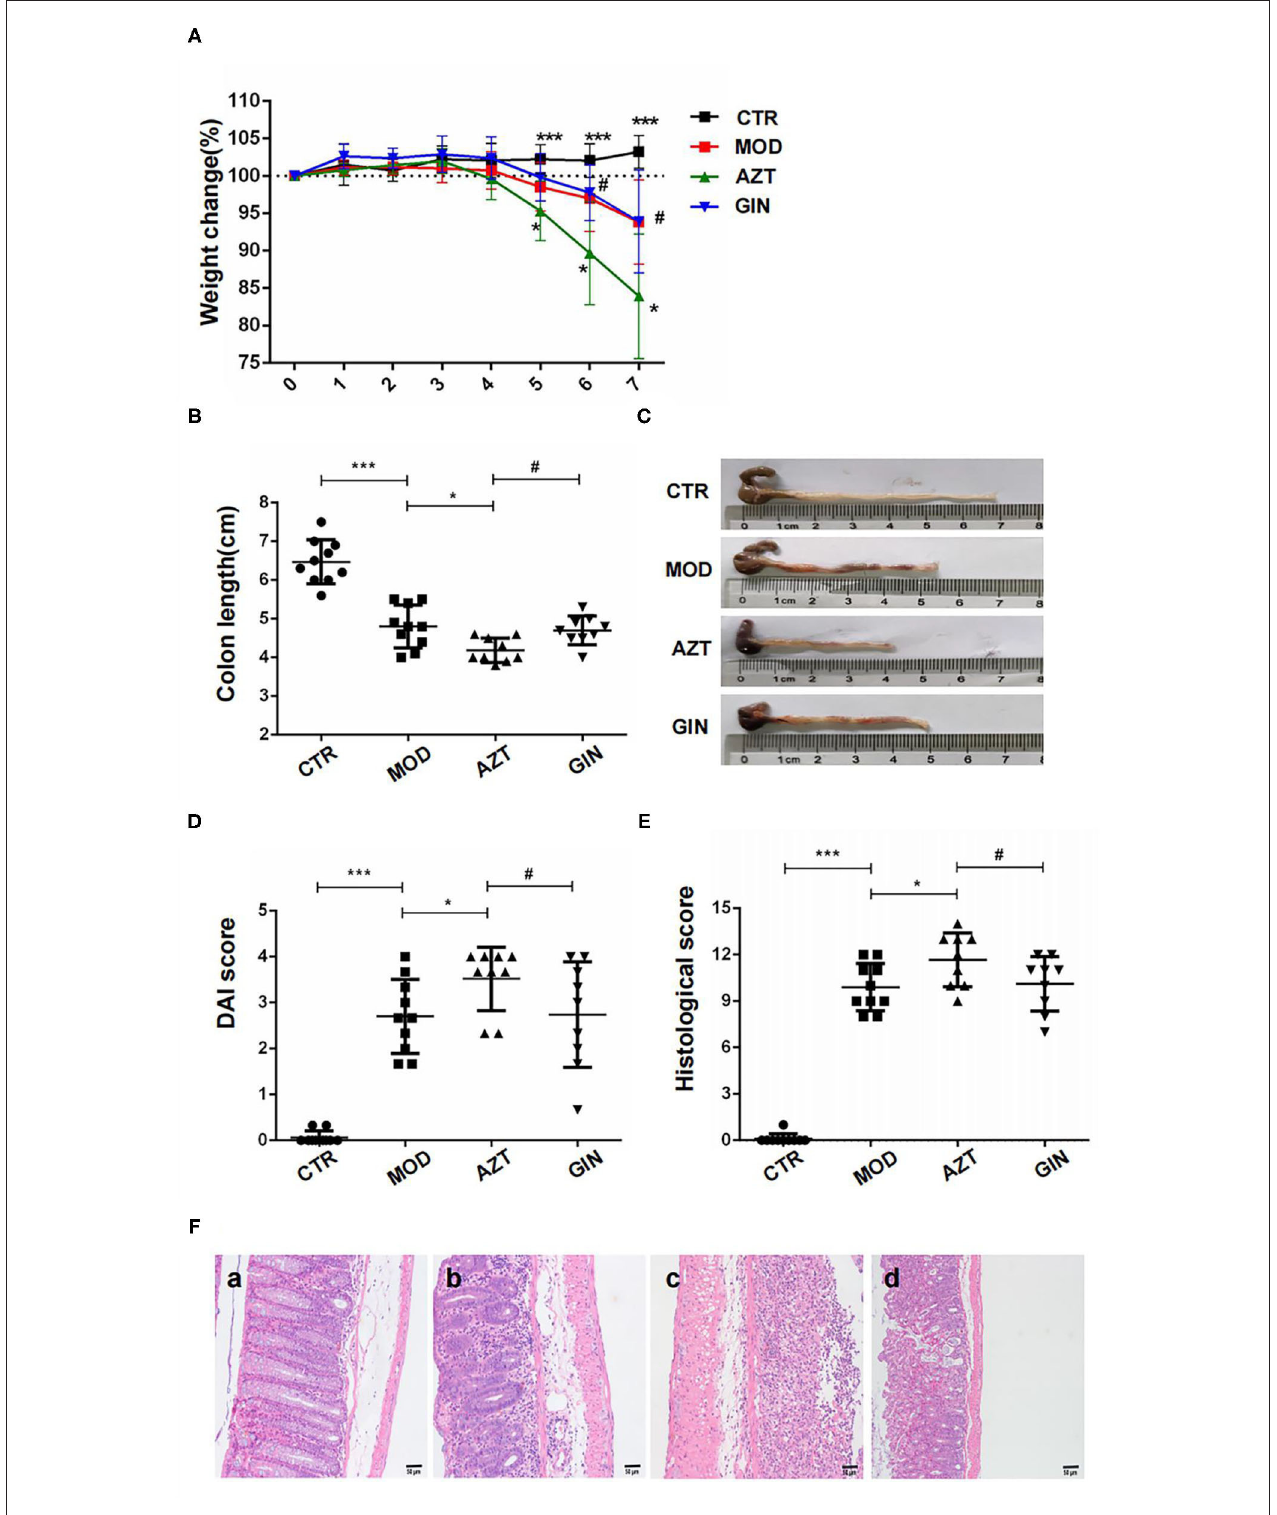
FIGURE 2 | Ginger reduces the susceptibility to DSS-induced colitis in mice exposed to AZT in early life. (A) Body weight loss, (B) and (C) colon length, (D) DAI score on day 6, (E) histological score, and (F) histological examination (magnification, × 200): (a) CTR group; (b) MOD group; (c) AZT group; and (d) GIN group. Data are represented as means ± SD ( n = 8–10). * p < 0.05 and *** p < 0.01 vs. model group; # p < 0.05 vs. AZT group.